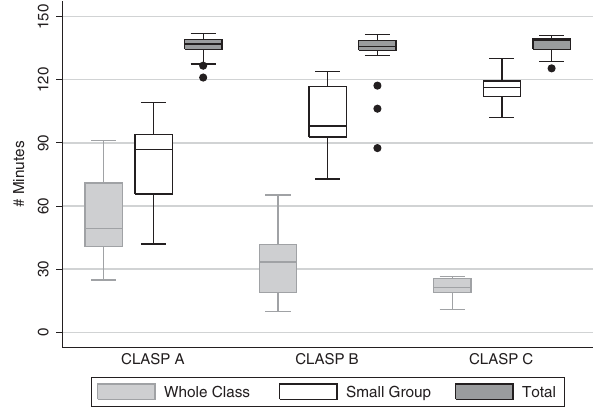
FIG. 3. Breakdown of time between whole class discussion and small group time is shown by course. Time is in minutes. A complete allotted DL period is 140 minutes. The box contains values from the 25th–75th percentile, with the median marked. The outliers are shown as dots, not connected to the